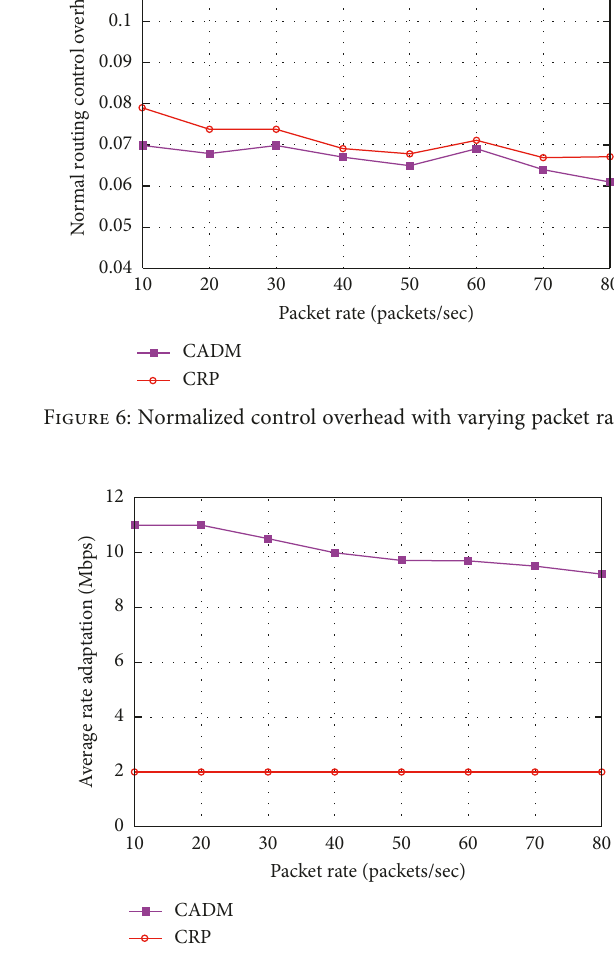
Figure 7: Average rate versus varying packet rates.